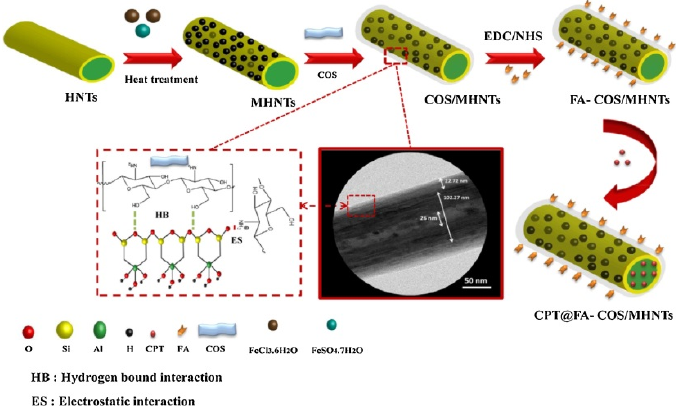
Figure 7. Schematic representation of the synthesis of camptothecin CPT@FA-COS/MHNTs. Reproduced with permission from [96].